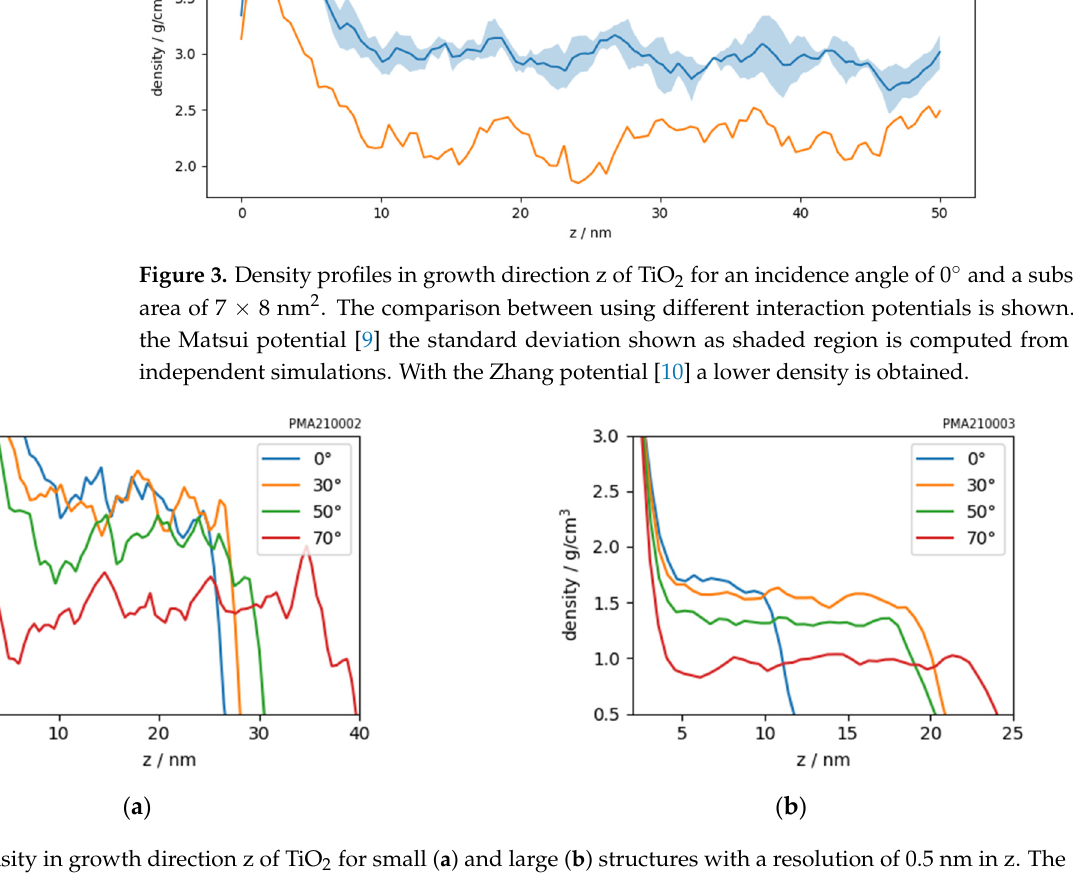
Figure 4. Density in growth direction z of TiO 2 for small ( a ) and large ( b ) structures with a resolution of 0.5 nm in z. The reduction of the density from small to large structures results not only from the change of the structure size but also from the change of the potential used.